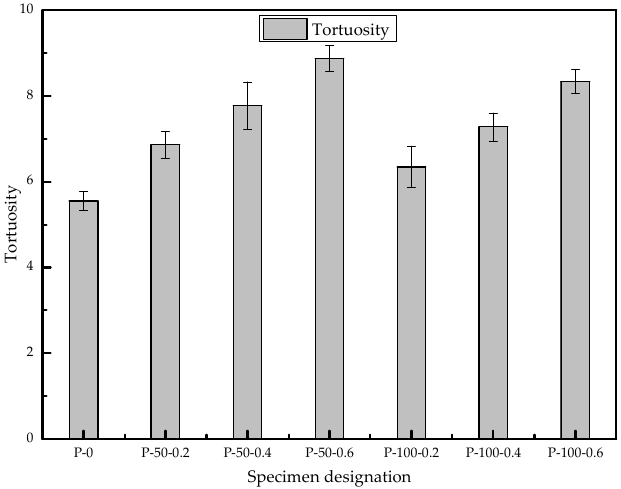
Figure 11. Comparison of the tortuosity of each sample group.